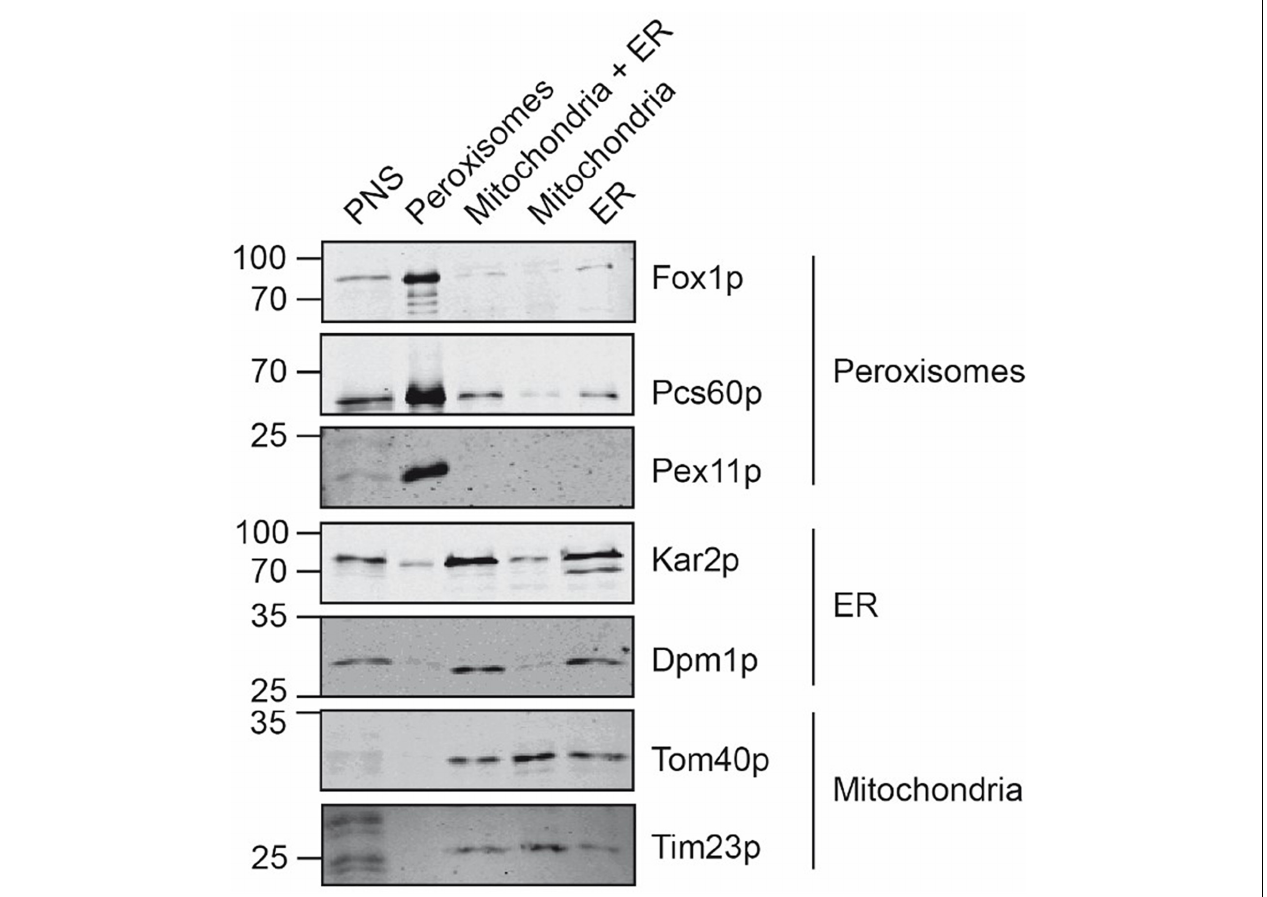
FIGURE 3 | Comparative analysis of isolated peroxisomes, mitochondria and ER. Equal amounts (20 µ g) of the postnuclear supernatant, purified peroxisomes, the mitochondria/ER pool after the first purification step, as well as purified mitochondria and ER were separated by SDS-PAGE and analyzed by immunoblotting using antibodies against Fox1p (peroxisomal matrix protein), Pcs60p (peroxisomal peripheral membrane and matrix protein), Pex11p (peroxisomal membrane protein), Kar2p (ER luminal protein), Dpm1p (ER membrane protein), Tom40p (mitochondrial outer membrane protein) and Tim23p (mitochondrial inner membrane protein).